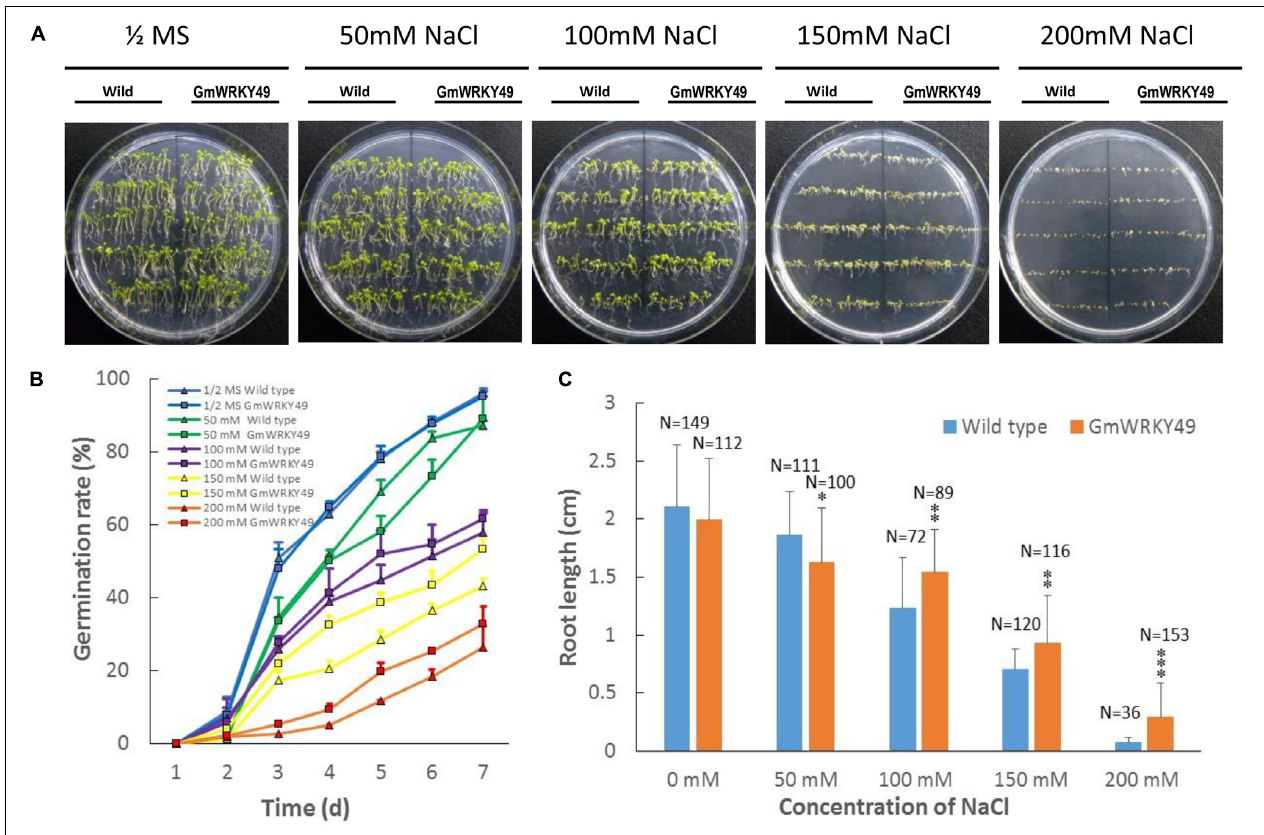
FIGURE 5 | Germination rate and root length of transgenic Arabidopsis seedlings overexpressing GmWRKY49 under different NaCl concentration treatments. Effect of different treatments on germination and root length of wild and transgenic Arabidopsis plants overexpressing GmWRKY49 . (A,B) Germination rate differences between WT and transgenic Arabidopsis seeds under different treatments. Photographs were taken at the end of experiments, after 7 days. (C) Roots’ length was measured after 14 days of 1 / 2 MS supplemented with 0, 50, 100, 150, and 200 mM NaCl treatments, respectively. P -values were calculated using Student’s t -test and ∗ P < 0.05, ∗∗ P < 0.01, and ∗∗∗ P < 0.001 compared with wild-type